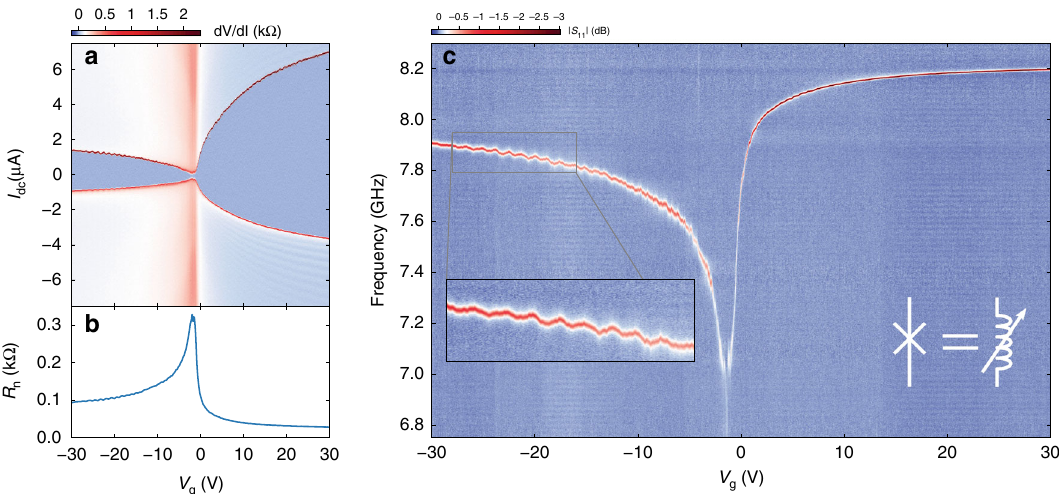
Fig. 2 Observation of the Josephson inductance of a ballistic graphene superconducting junction. a Differential resistance across the gJJ for a wide gate- voltage range. Dark blue denotes area of zero resistance. The device shows signatures of FP oscillations on the p-doped side. b Normal state resistance of the gJJ versus gate voltage. c Microwave spectroscopy of the device in the superconducting state versus gate voltage, plotted as the amplitude of the re fl ection coef fi cient | S 11 | after background subtraction. The graphene junction acts as a tunable inductor in the microwave circuit, resulting in a cavity frequency that is tuned with gate voltage. Inset: The resonance frequency oscillates in phase with the oscillations in a ,